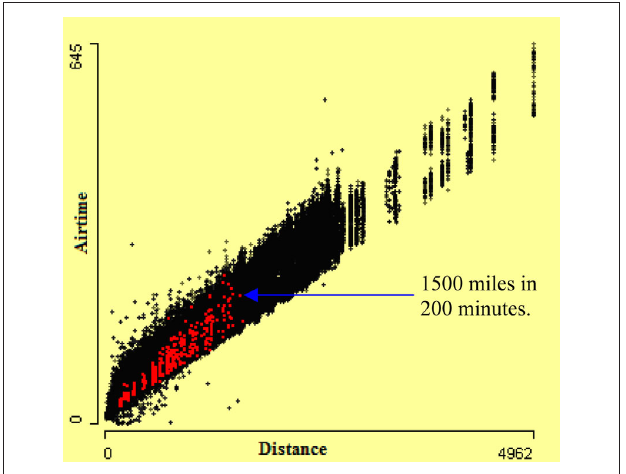
FIgurE 4 | Scatterplot of airtime by distance. Cases with aircraft type “balloon” are highlighted. Many of them are as fast as a jet plane.